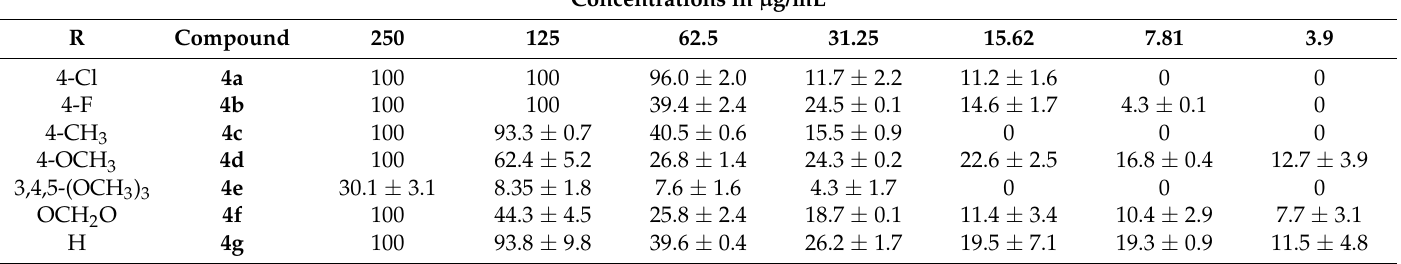
Table 3. MIC 100 , MIC 80 and MIC 50 values in µg/mL of compounds 4a – c and 4g against clinical isolates of C. neoformans .